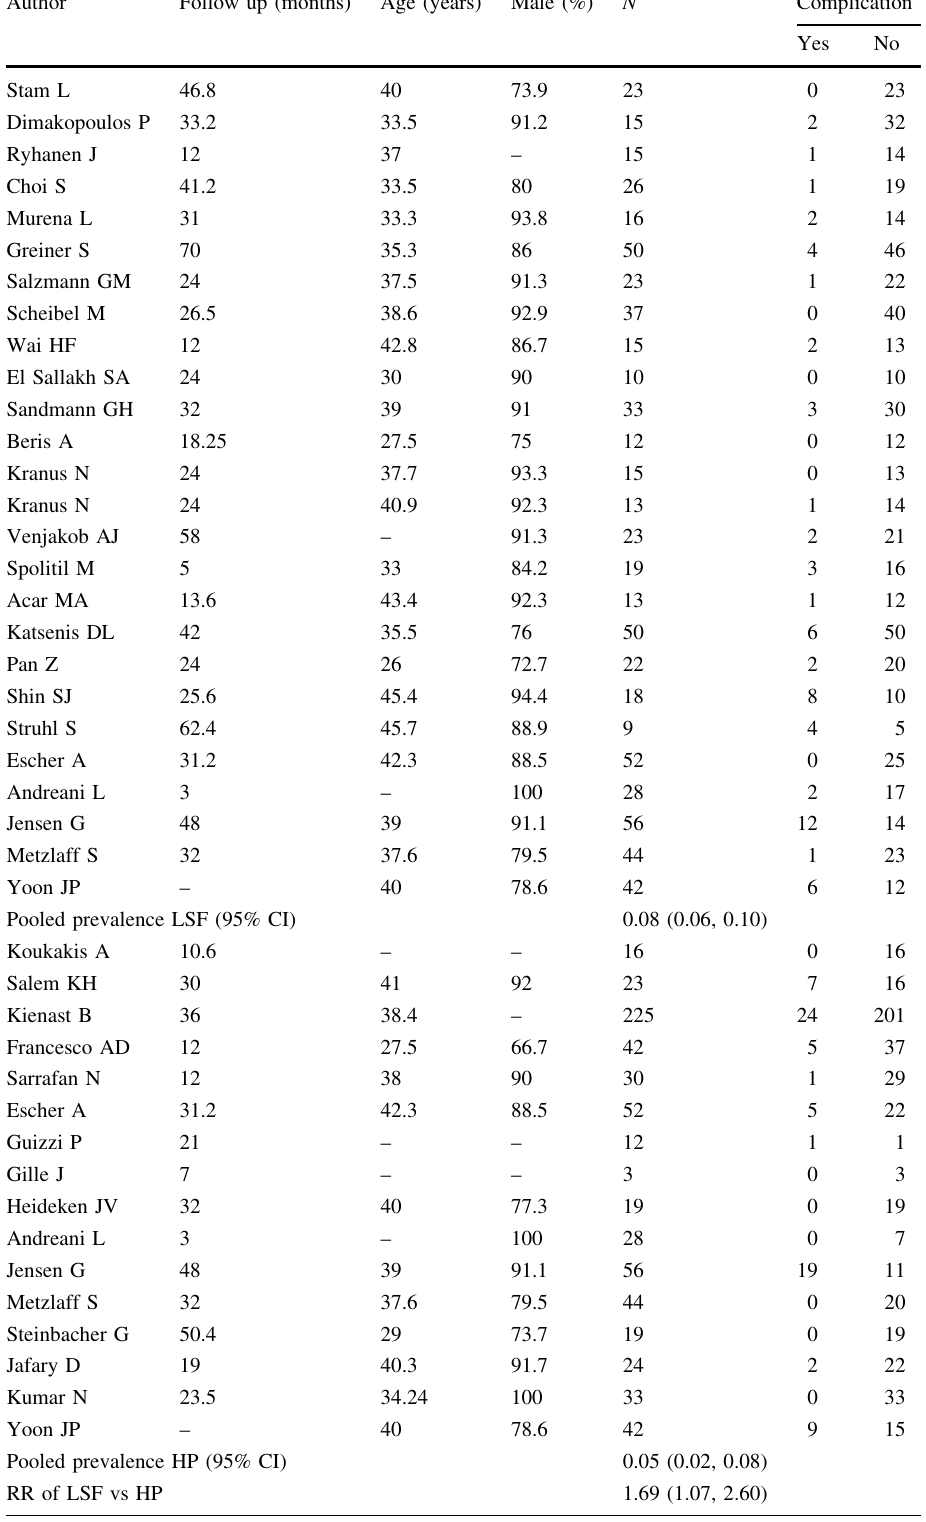
Table 3 Estimation of the pooled prevalence of post- operative complication of LSF and